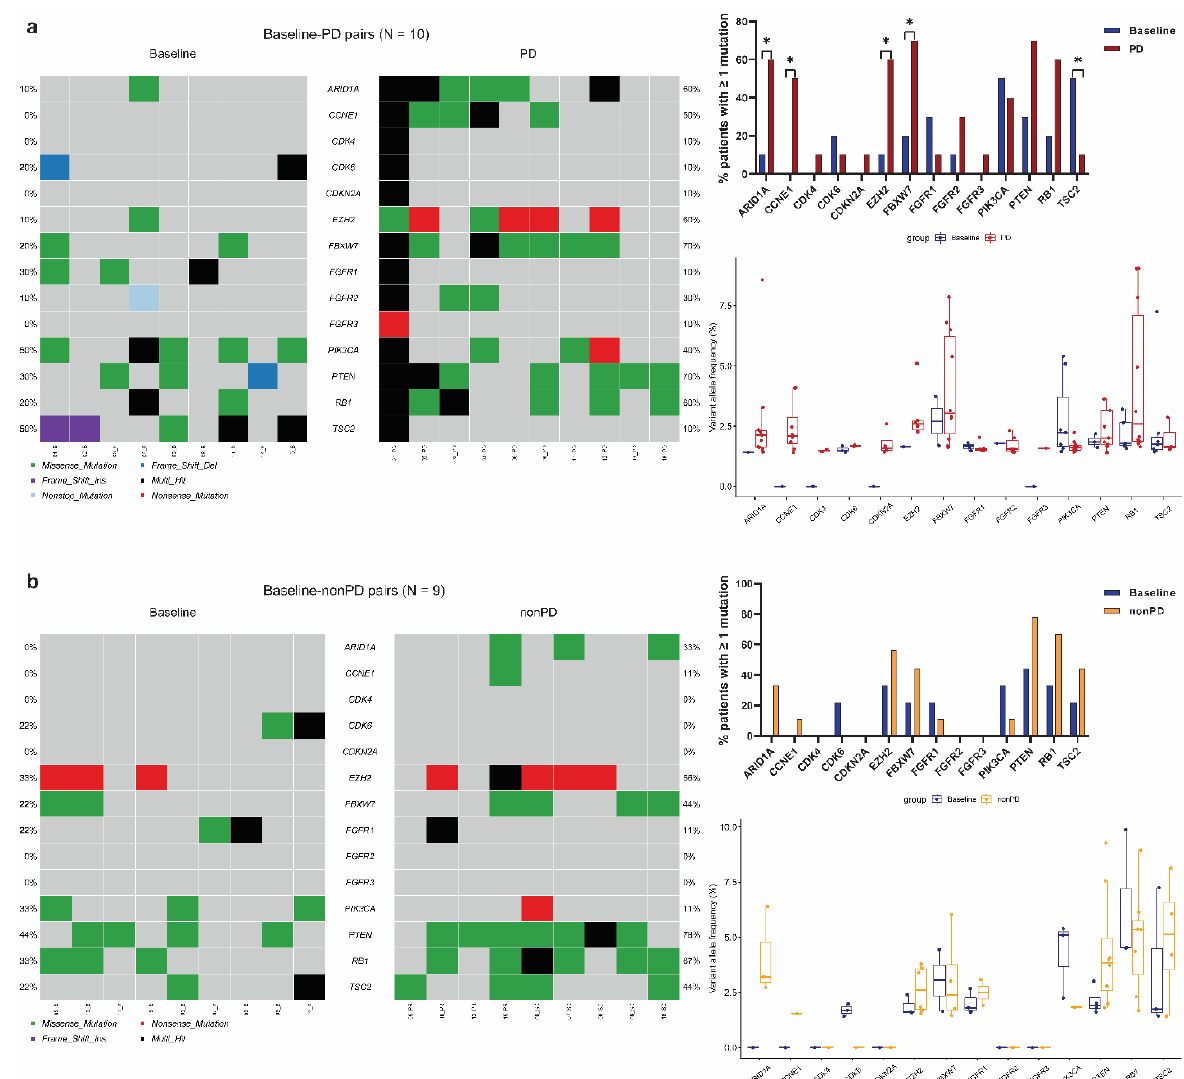
Figure 2. Differences in mutated gene frequencies and variant allele frequencies between samples collected at baseline and the corresponding paired samples collected at follow-up from each patient. Follow-up samples were categorized as PD or nonPD. Comparisons were conducted in baseline-PD pairs ( a ) and in baseline-nonPD pairs ( b ). PD: progressive disease. nonPD indicates without pro- gression, including stable disease and partial response in this study. * represents p <